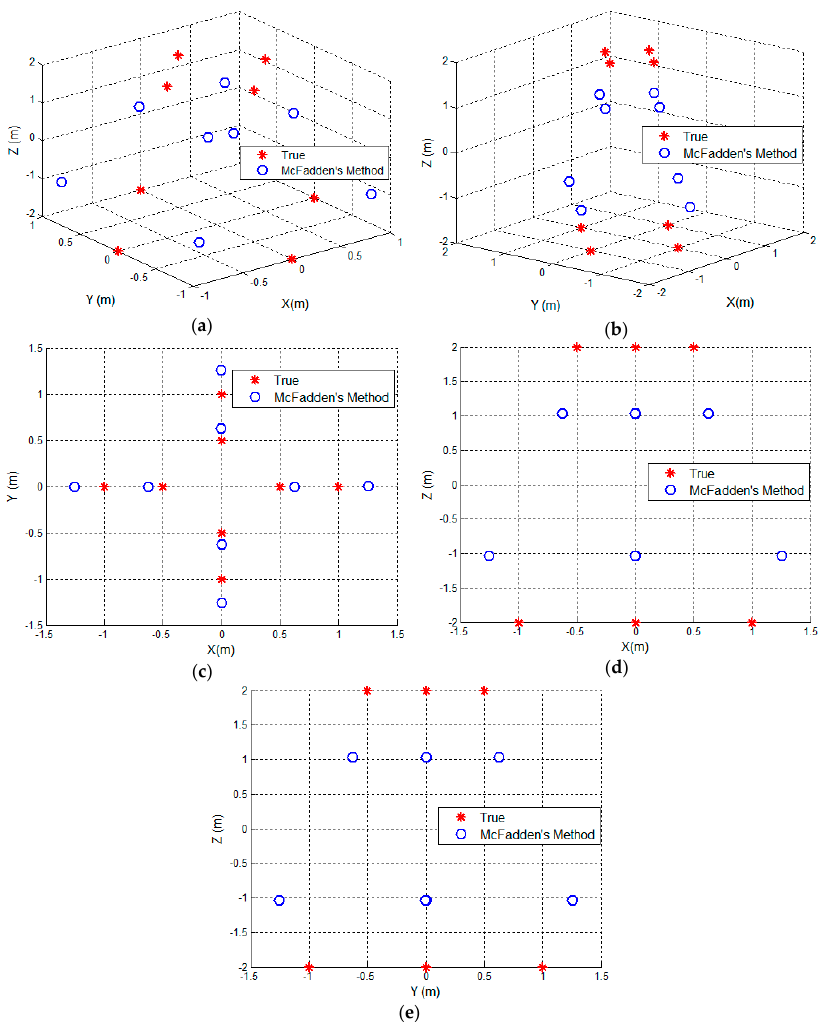
Figure 7. The reconstructed result using McFadden’s method [20]. ( a ) The distribution of the reconstructed 3D scattering centers before transformation; ( b ) The distribution of the 3D scattering centers after transformation; ( c ) the distribution on XY plane; ( d ) the distribution on XZ plane; ( e ) the distribution on YZ plane.